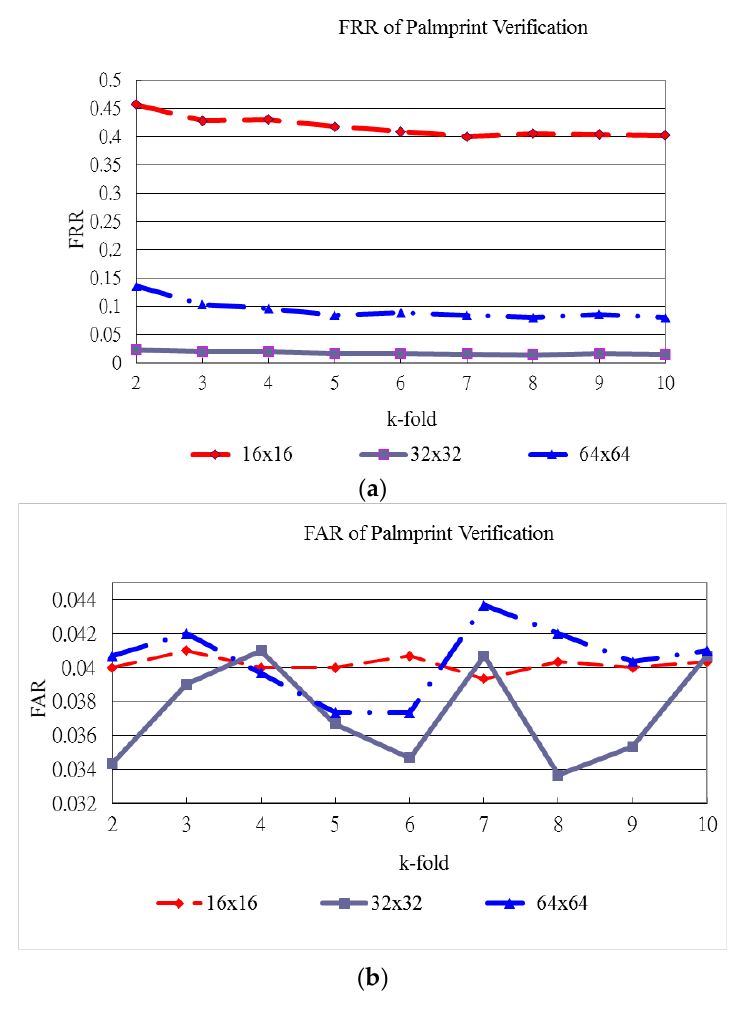
Figure 15. FRR and FAR for palmprint verification. ( a ) FRR of palmprint verification; ( b ) FAR of palmprint verification.